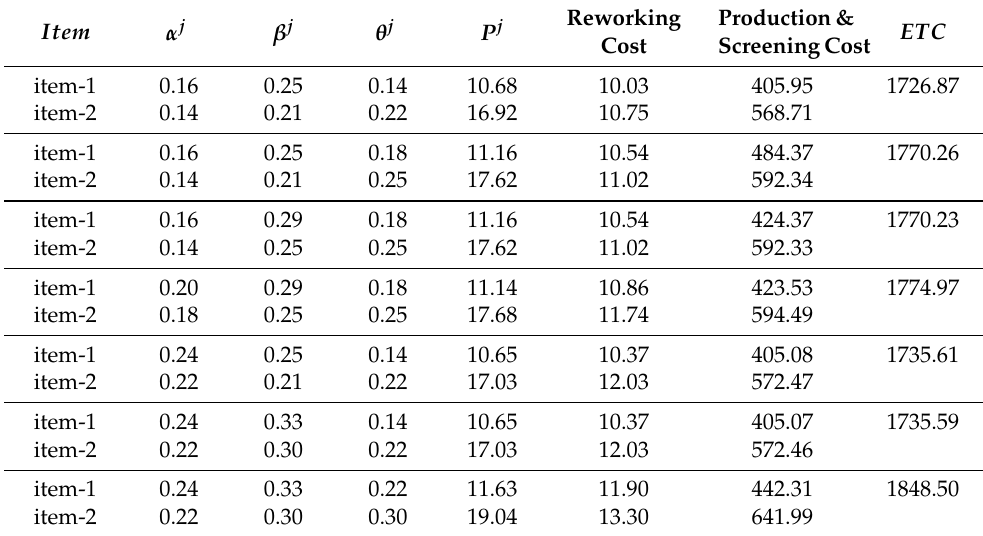
Table 6. Comparison results for different values of learning effect parameters α j and β j .